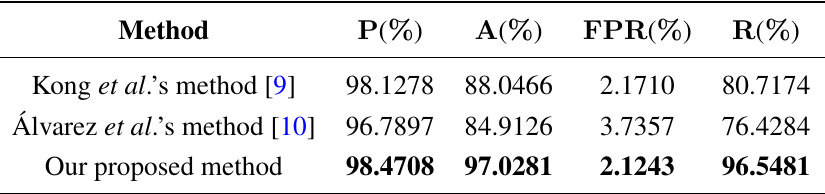
Table 3. Quantitative results on the OffRoadScene database.